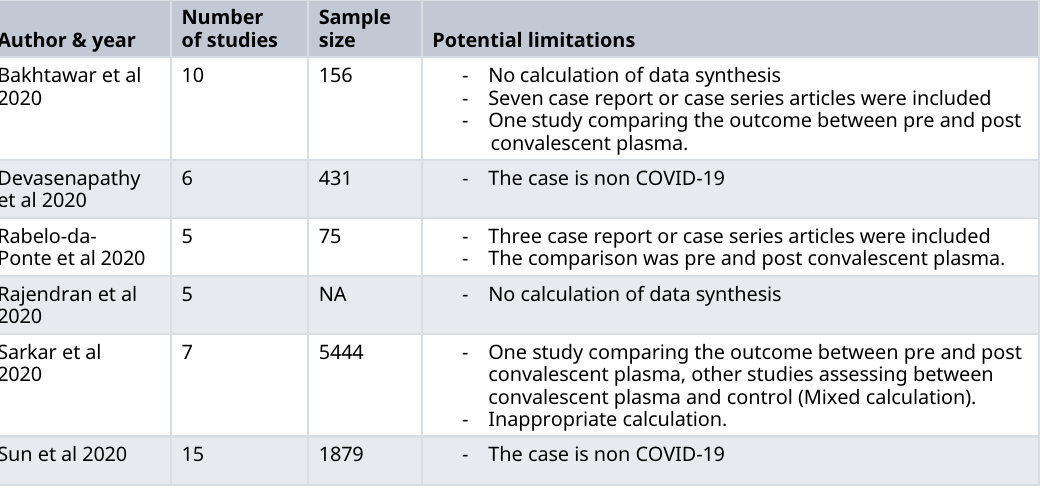
Table 2. Previous systematic review and meta-analyses and some potential